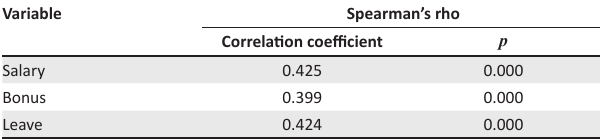
TABLE 3: Spearman’s rho tests for the compensation